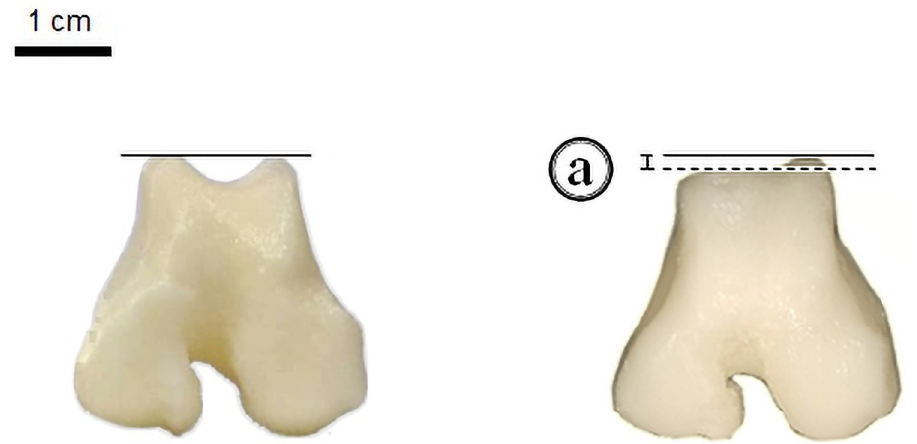
Fig 3. Height difference: (a) = 0.2 cm in the depth of the trochlear groove and medial condyle in the normal piece (left) and the edited one (right).